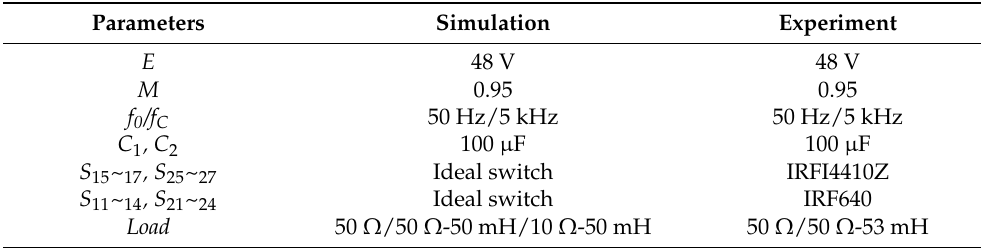
Table 3. Parameters of the cascaded multilevel